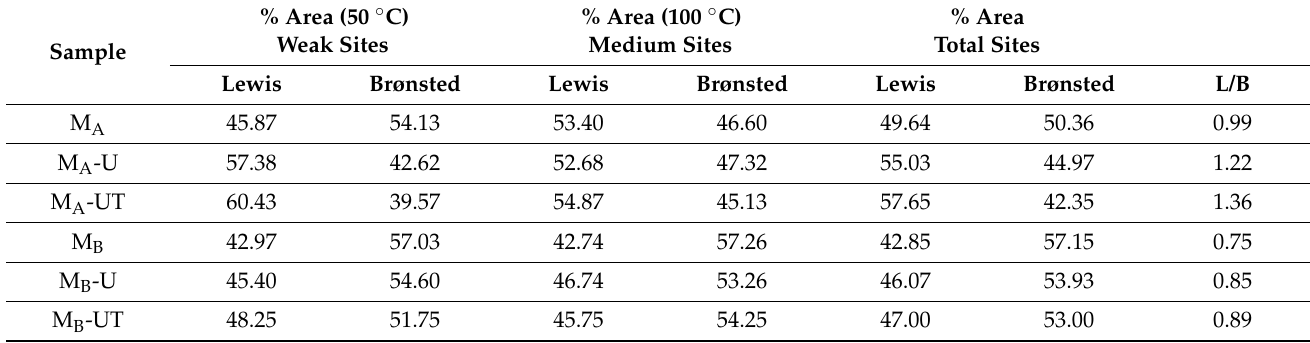
Table 4. FTIR of CO